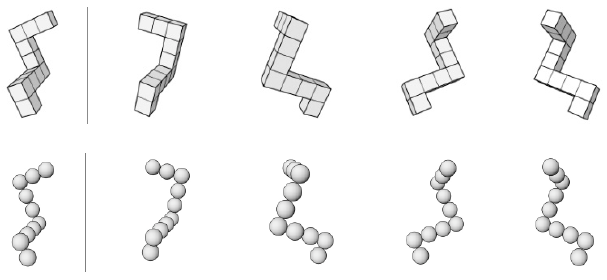
Figure 1. Example items (C-MRT in the upper row and P-MRT in the lower row).